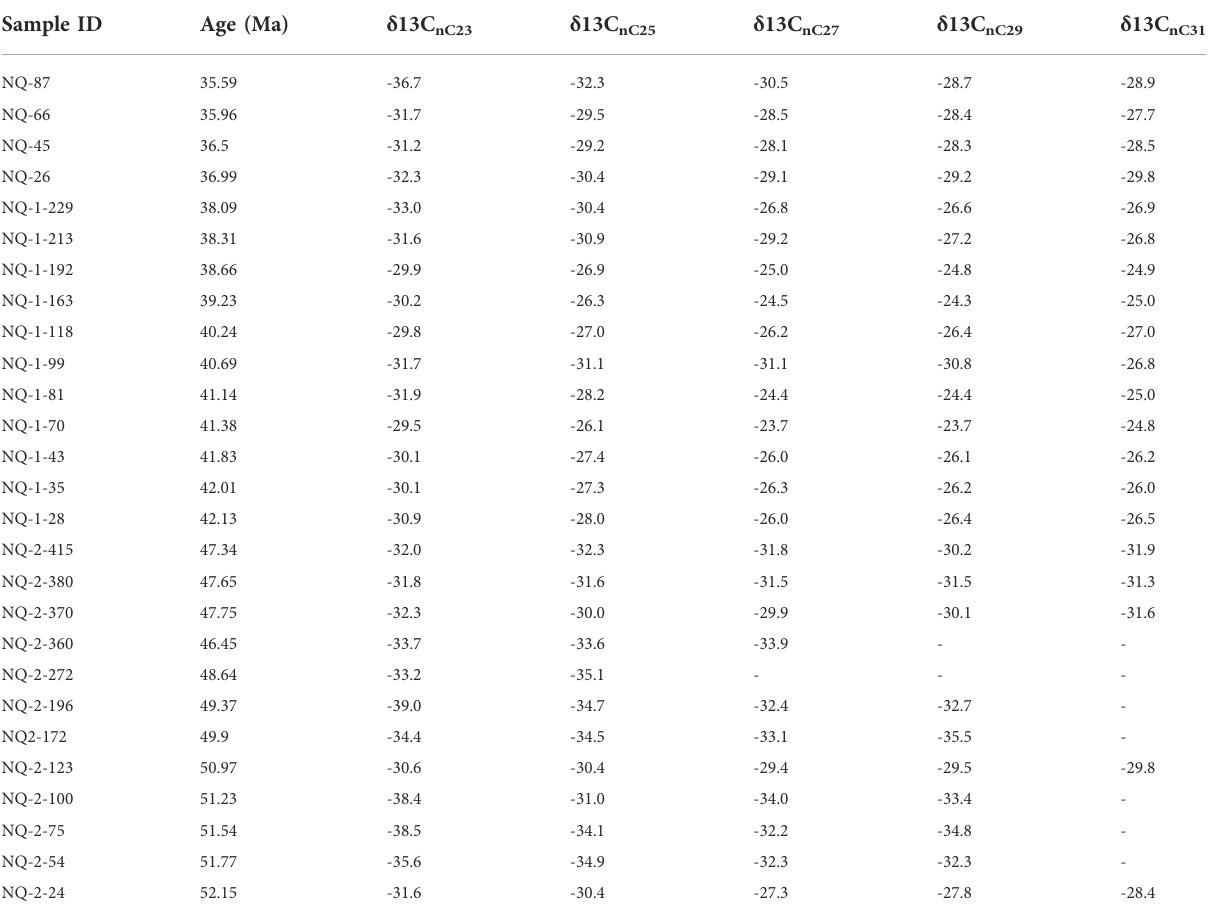
TABLE 2 Compound-speci fi c carbon isotope of samples from the Nangqian